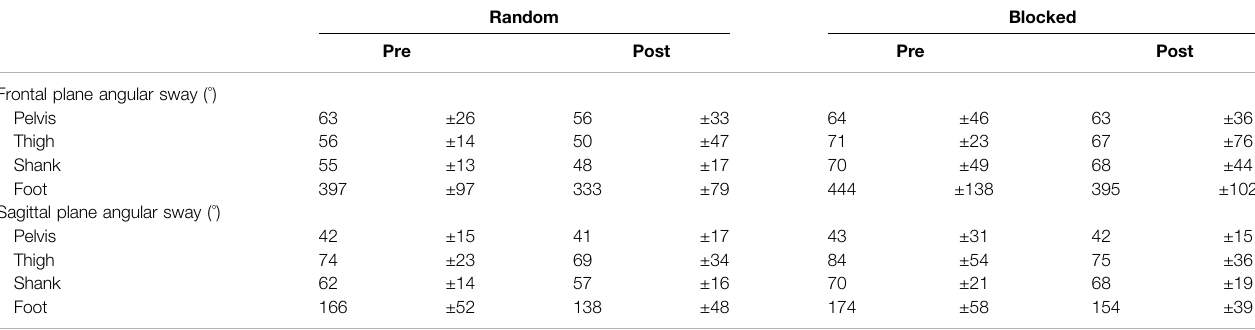
TABLE 1 | Frontal and sagittal plane segmental angular sway values (mean ± SD) for the random and the blocked conditions obtained during the static balance test (10-s- long single-leg standing on the convex surface of a Togu ® Jumper). Values represent angle-time curve length.